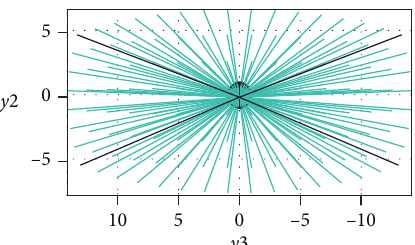
Figure 3: Front projection of the 3D lidar’s view for one obstacle in 15m.